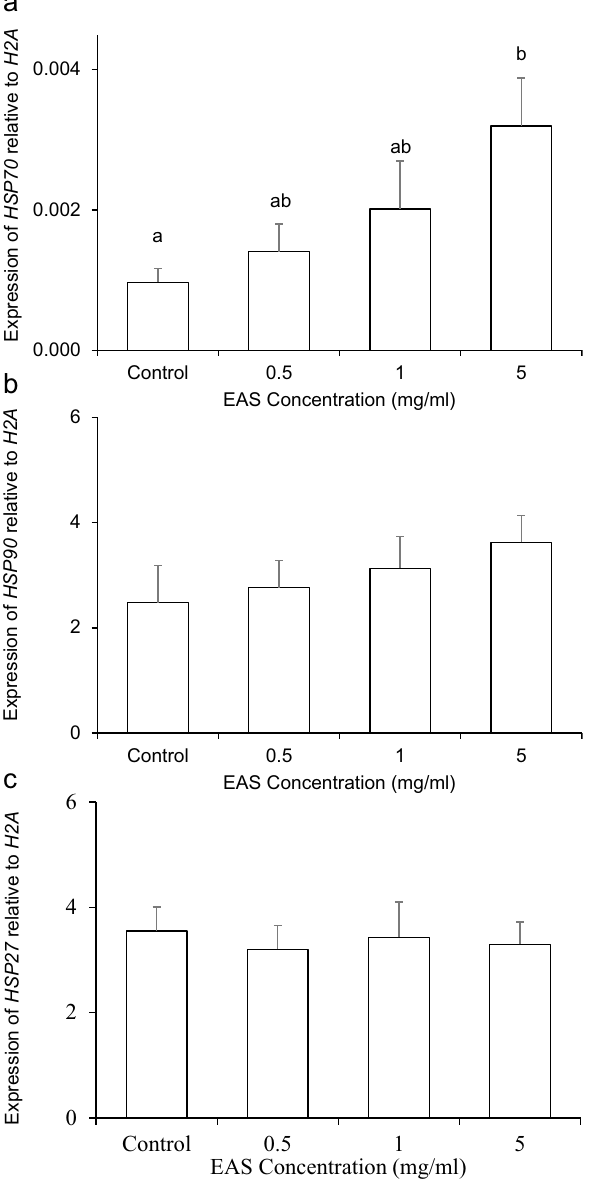
Figure 1. Effect of EAS concentration on the expression of HSP70 , HSP90 , and HSP27 in bovine CG cells. Cells were treated with various concentrations of EAS (0.5, 1, and 5 mg/ml) for 6 h at 38.5 °C and analyzed for gene expression. The expression levels of HSP70, HSP90, and HSP27 were examined using real-time quantitative PCR, normalized to H2AFZ as a reference gene. ( a ) HSP70 , ( b ) HSP90 , and ( c ) HSP27 . Data are shown as the mean ± SEM, n = 5, a vs. b ( P <